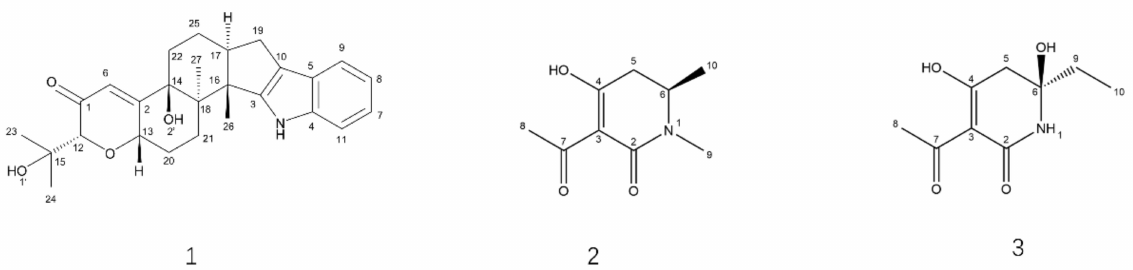
Figure 7. Structures of Compounds 1 – 3